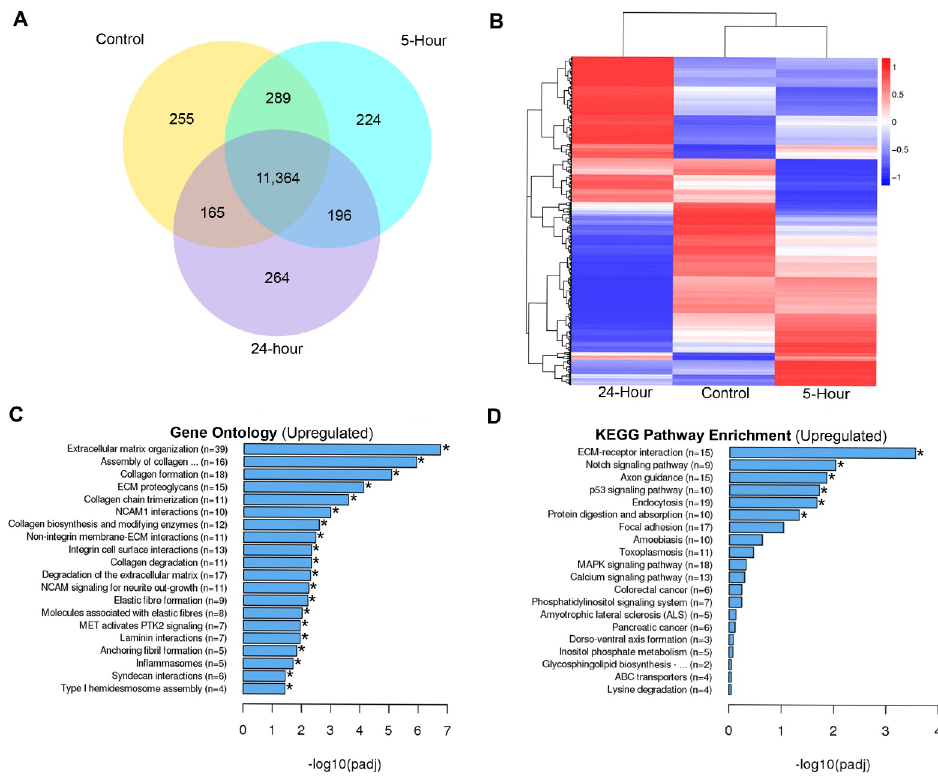
Fig 1. Differential expression analysis of T . denticola challenged hPDL cells. Total RNA was extracted from healthy patient-derived hPDL cells challenged with Td-WT bacteria at a MOI of 50 for 2-hours in media free of supplements followed by 3 and 22-hours in media supplemented with 10% FBS, 1% Pen Strep and 1% Amphotericin B. Mean FPKM values were used for downstream analysis (n = 3 patient replicates). A) Overlapping and differentially expressed genes between control, 5-hour and 24-hour incubation groups visualized using a Venn diagram. B) Hierarchical clustering analysis was used to determine similarity of transcriptome profiles based on differential expression as a heatmap. Red (Upregulation) to blue (Downregulation) color gradient of heatmap represents normalized gene expression as row Z-scores. C) Top 20 enriched Gene Ontology terms of hPDL cells challenged for 2-hours followed by a 22-hour incubation using the Reactome nomenclature. Statistical significance was assessed using a Kolmogorov- Smirnov test followed by Benjamini-Hochberg correction (p < 0.05). D) Top 20 enriched signaling pathways of hPDL cells challenged for 2-hours followed by a 22-hour incubation using the Kyoto Encyclopedia of Genes and Genomes (KEGG) database. Statistical significance was assessed using a Kolmogorov-Smirnov test followed Benjamini- Hochberg correction (p <